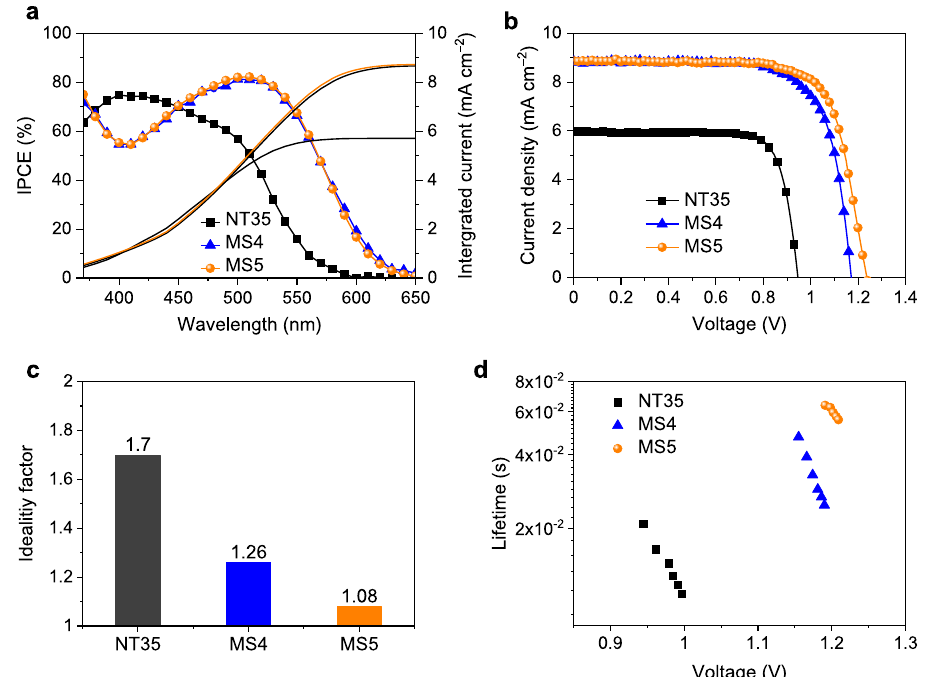
Fig. 2 Photovoltaic performance and interfacial charge recombination of co-sensitizers. a Incident photon-to-electron conversion ef fi ciency (IPCE) of the dye-sensitized solar cells (DSCs) based on the co-sensitizers of NT35, MS4, and MS5. The solid lines show the corresponding integrated photocurrent calculated from the IPCE. b Current density – voltage curves of the DSCs with NT35, MS4, and MS5 measured under AM1.5G, 100 mWcm − 2 condition. c The ideality factors of the DSCs based on the dyes NT35, MS4, and MS5. d Comparison of electron lifetimes measured with the small-pulse transient photovoltage decay method against voltage. Table 1 Photovoltaic parameters of DSCs measured under standard AM1.5G